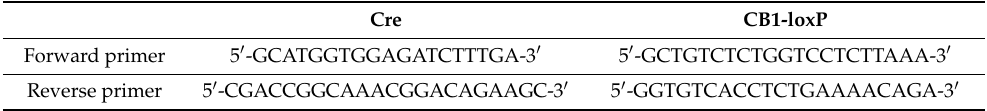
Table 2. Sequences of Cre and CB1-loxP primers used for genotyping.